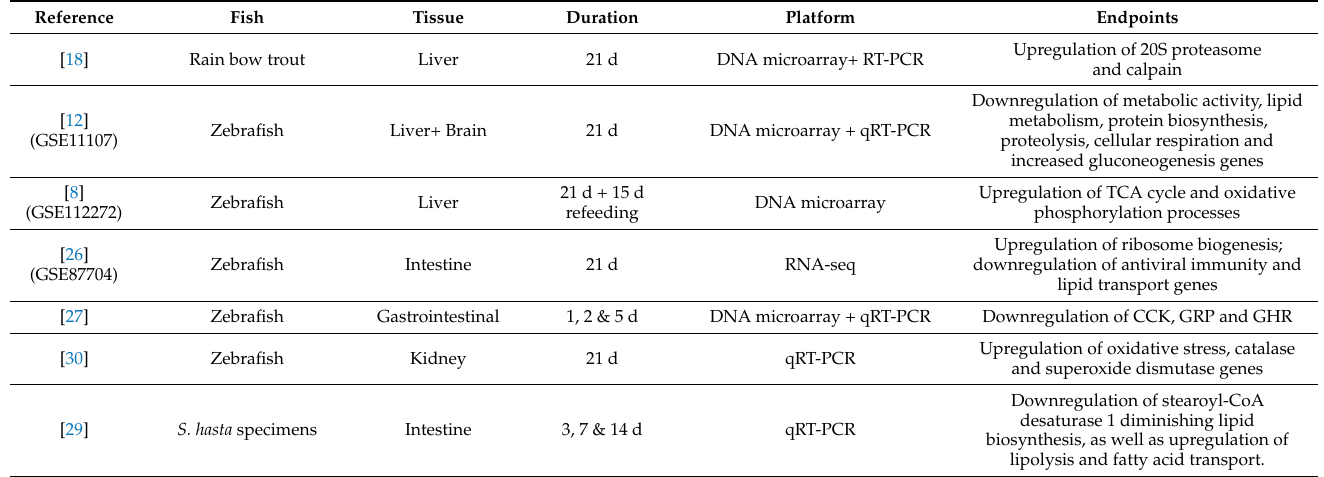
Table 1. Summary of transcriptomics studies performed to investigate starvation in